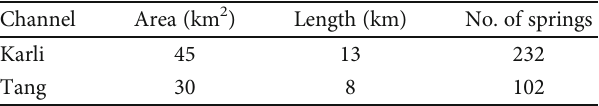
Table 3: Key data of catchment areas of Karli and Tung channels (after Hoeg et al. [8] and NESPAK and GSP